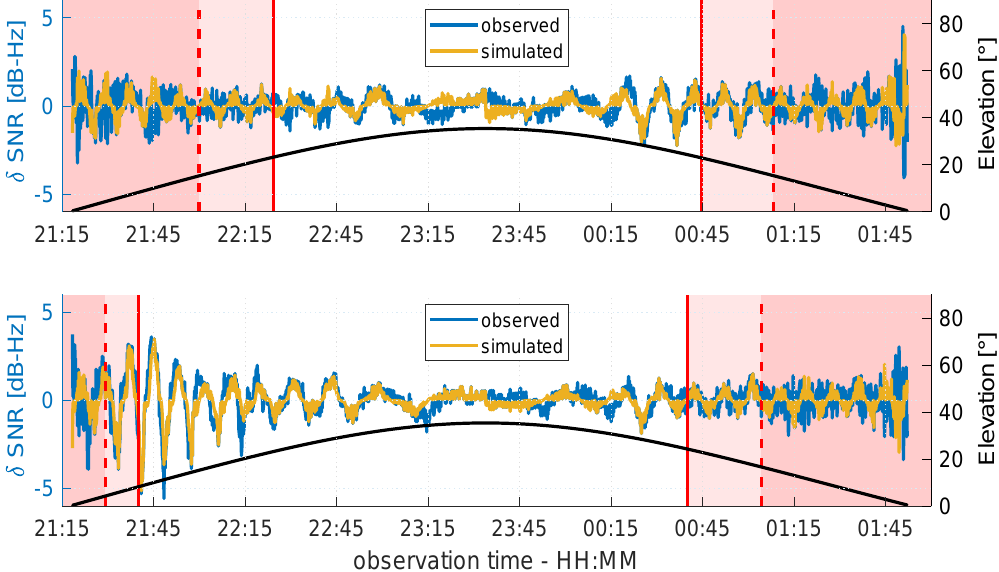
Figure 20. Observed (blue) and simulated (ocher) δ -SNR time series of G14 for antenna A ( top panel) and antenna B ( bottom panel). The black line shows the elevation angle of G14 during the observation